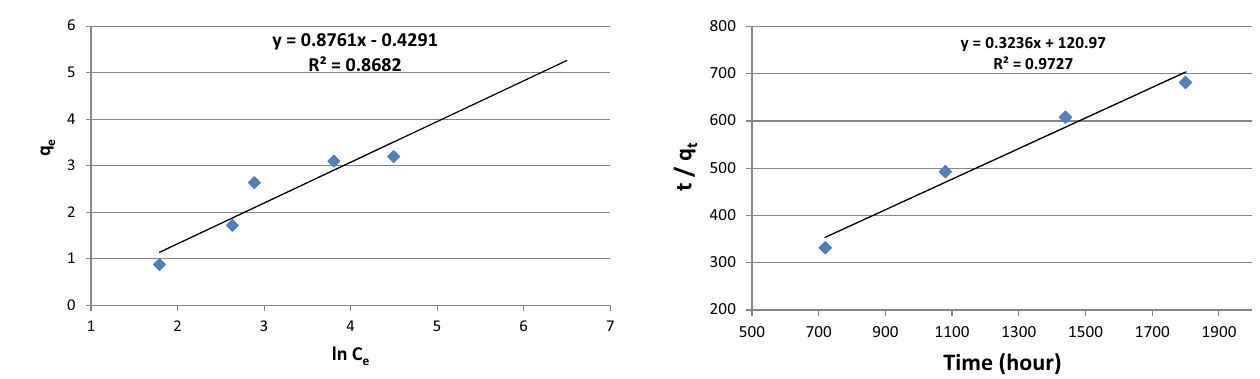
Fig. 15 PSO model application for CR on Aspergillus niger